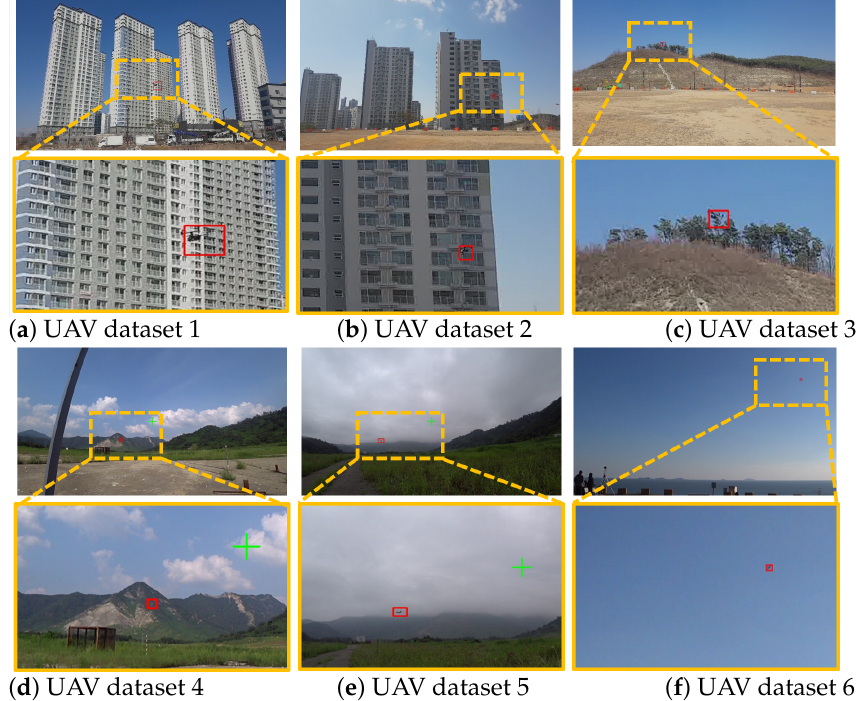
Figure 4. Qualitative results 1 using our UAV datasets. Red boxes denote visual tracking results of the proposed method.